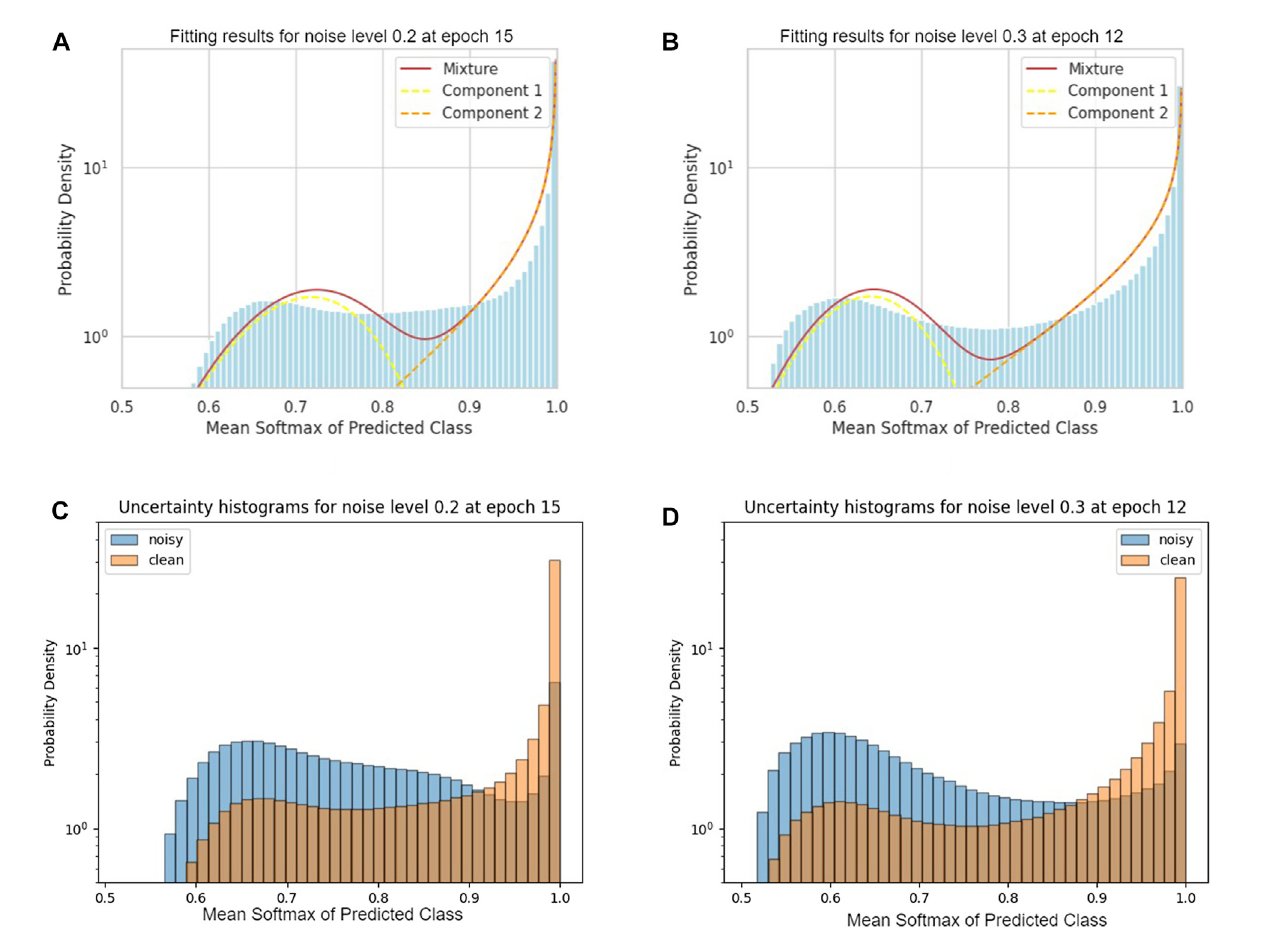
FIGURE 2 Mixed beta distributions fi t and uncertainty histograms of clean and noisy samples. (A) Mixed beta distributions fi t by the betamix algorithm for training data with 20% noise (B) Mixed beta distributions fi t by the betamix algorithm for training data with 30% noise (C) Uncertainty histograms of clean and noisy samplesfortrainingdatawith20%noise (D) Uncertaintyhistogramsofcleanandnoisysamplesfortrainingdatawith30%noise.Uncertaintieswerecomputed by taking the mean softmax value of the predicted class μ